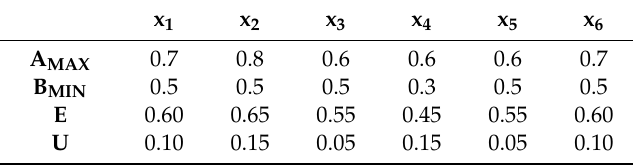
Table 3. Greatest eigen fuzzy set (GEFS) of R MAX and SEFS of R